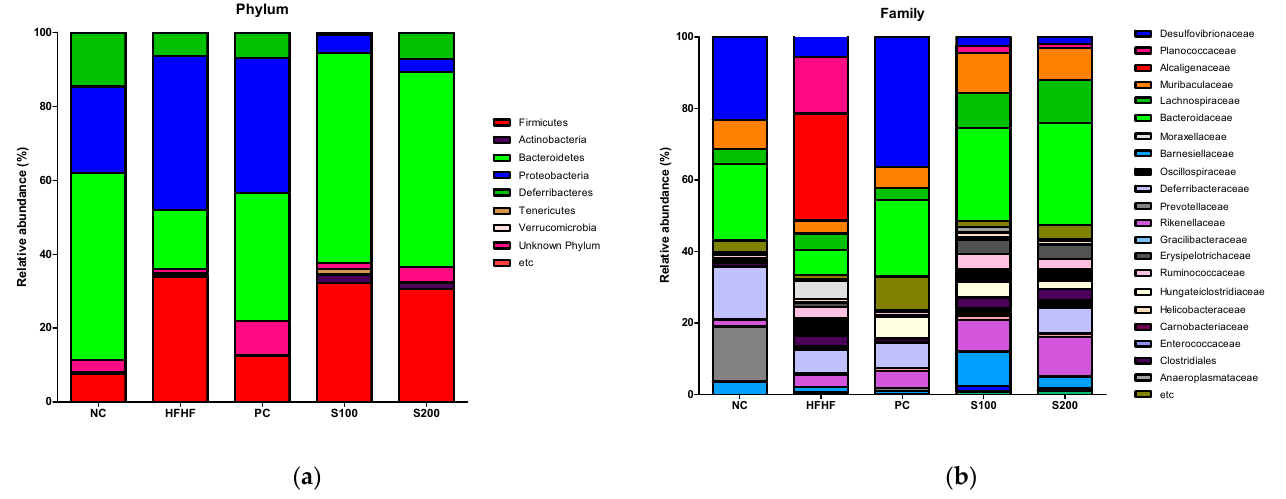
Figure 8. Effects of Bombyx mori (SW) treatment on the fecal microbial diversity in HFHF-fed mice. ( a ) Relative abundances of the gut microbiota at phylum level and ( b ) family level. NC, normal control; HFHF, 45% high fat diet with 10% fructose in the drinking water; PC, positive control (HFHF diet with 1% silymarin S100); S100, HFHF diet with SW (100 mg/kg/day); S200, HFHF diet with SW (200 mg/kg/day).